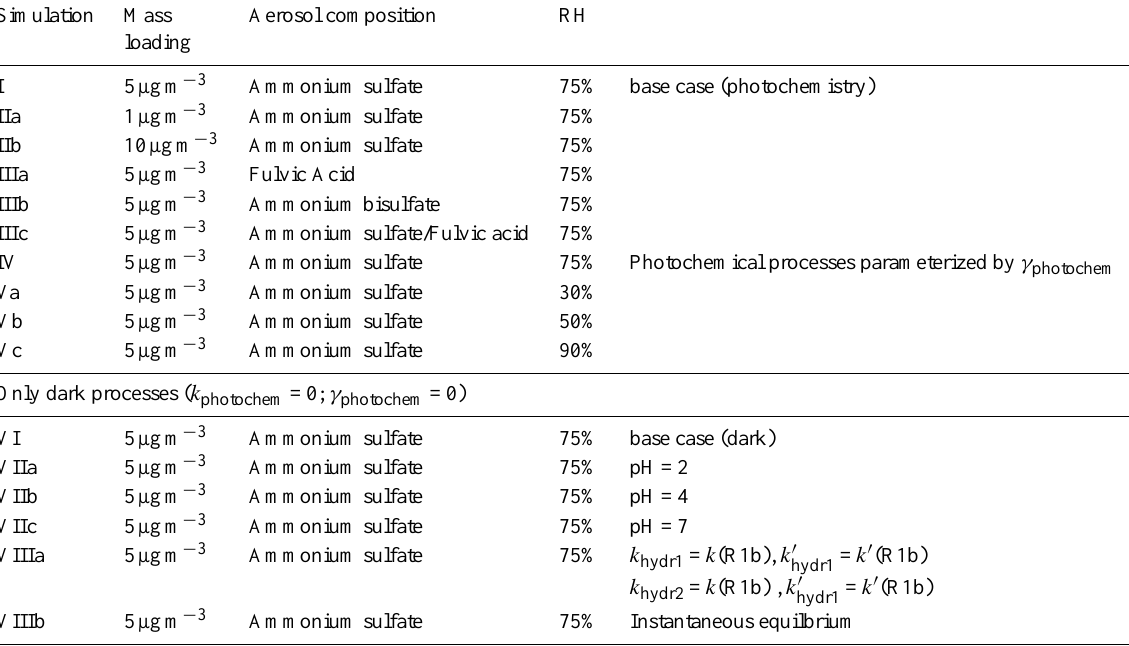
Table 7. Input parameters for the box model used to evaluate SOA formation from glyoxal under atmospheric conditions. These model simulations include all reaction parameters in Table 2; results are shown in Fig.